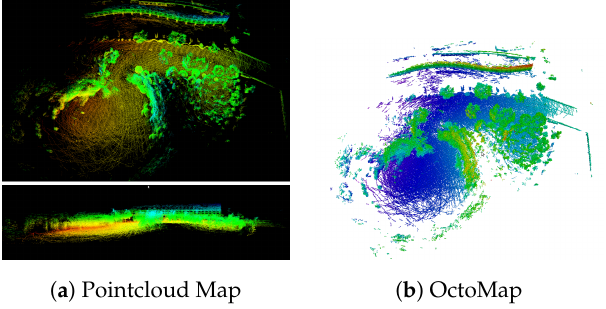
Figure 7. Result of Mapping